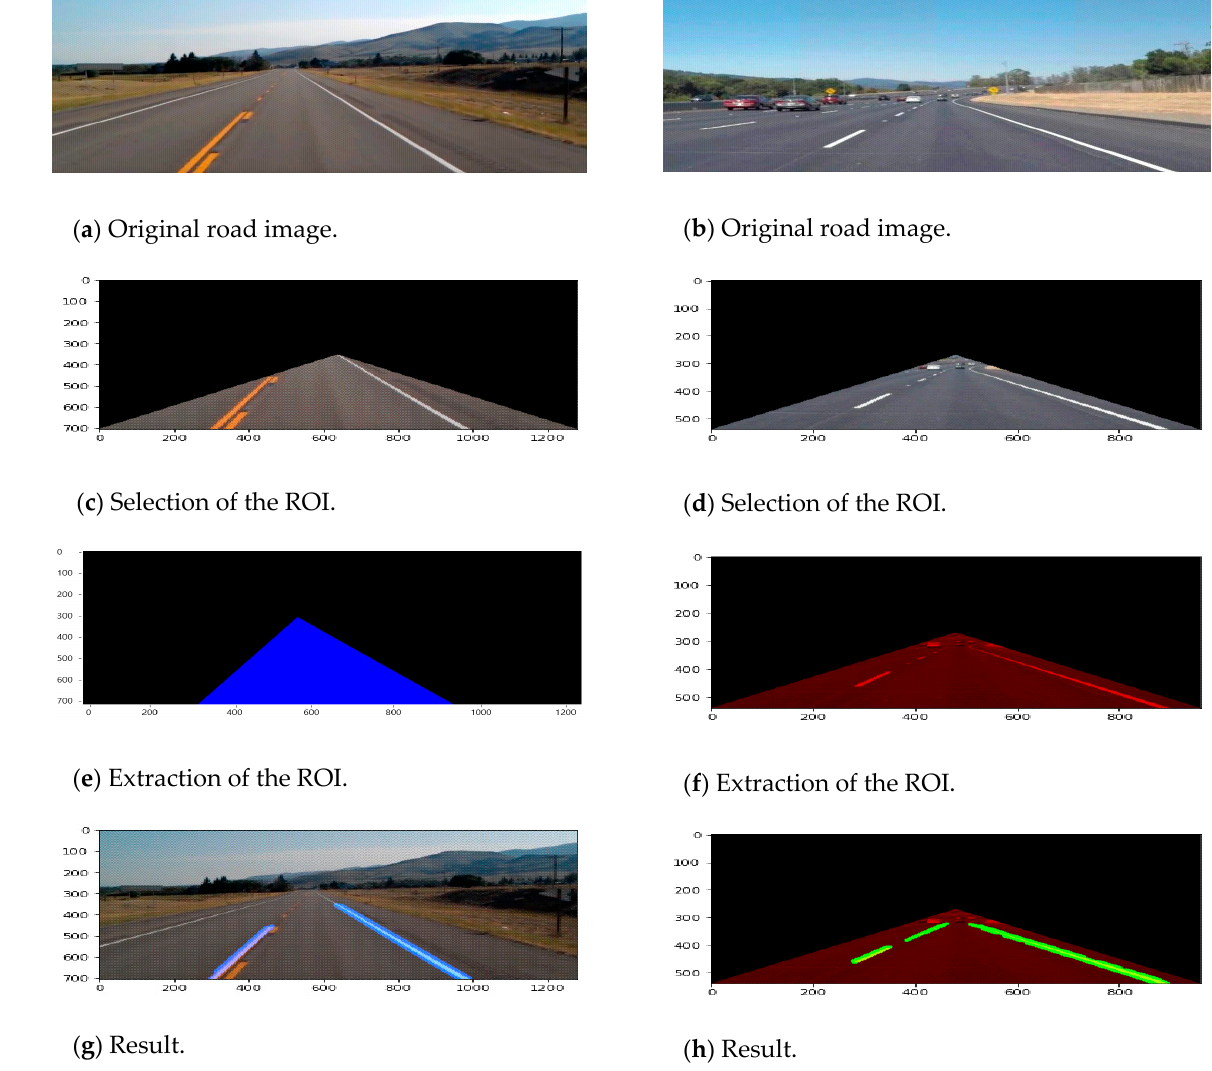
Figure 8. Edge detection and road region of interest extraction.